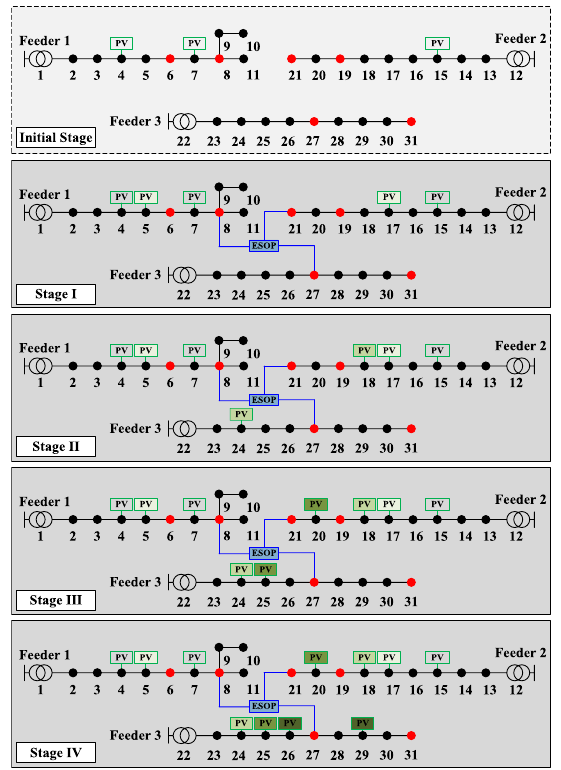
Fig. 6 Planning result of the network based on ESOP in Case III Fig. 7 Planning results of the network based on ESOP in Case